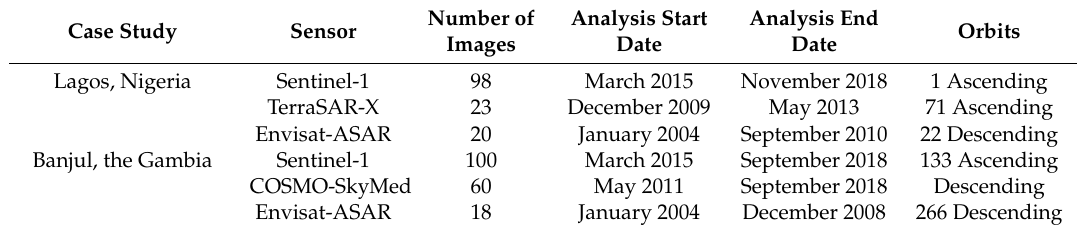
Figure 2. Data availability for Banjul and Lagos. Table 3. Summary of data availability for the two case studies presented.